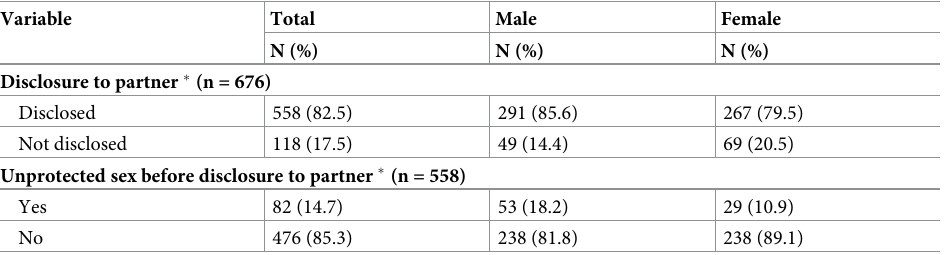
Table 3. HIV status disclosure to most recent sexual partner and unprotected sex prior to disclosure, by